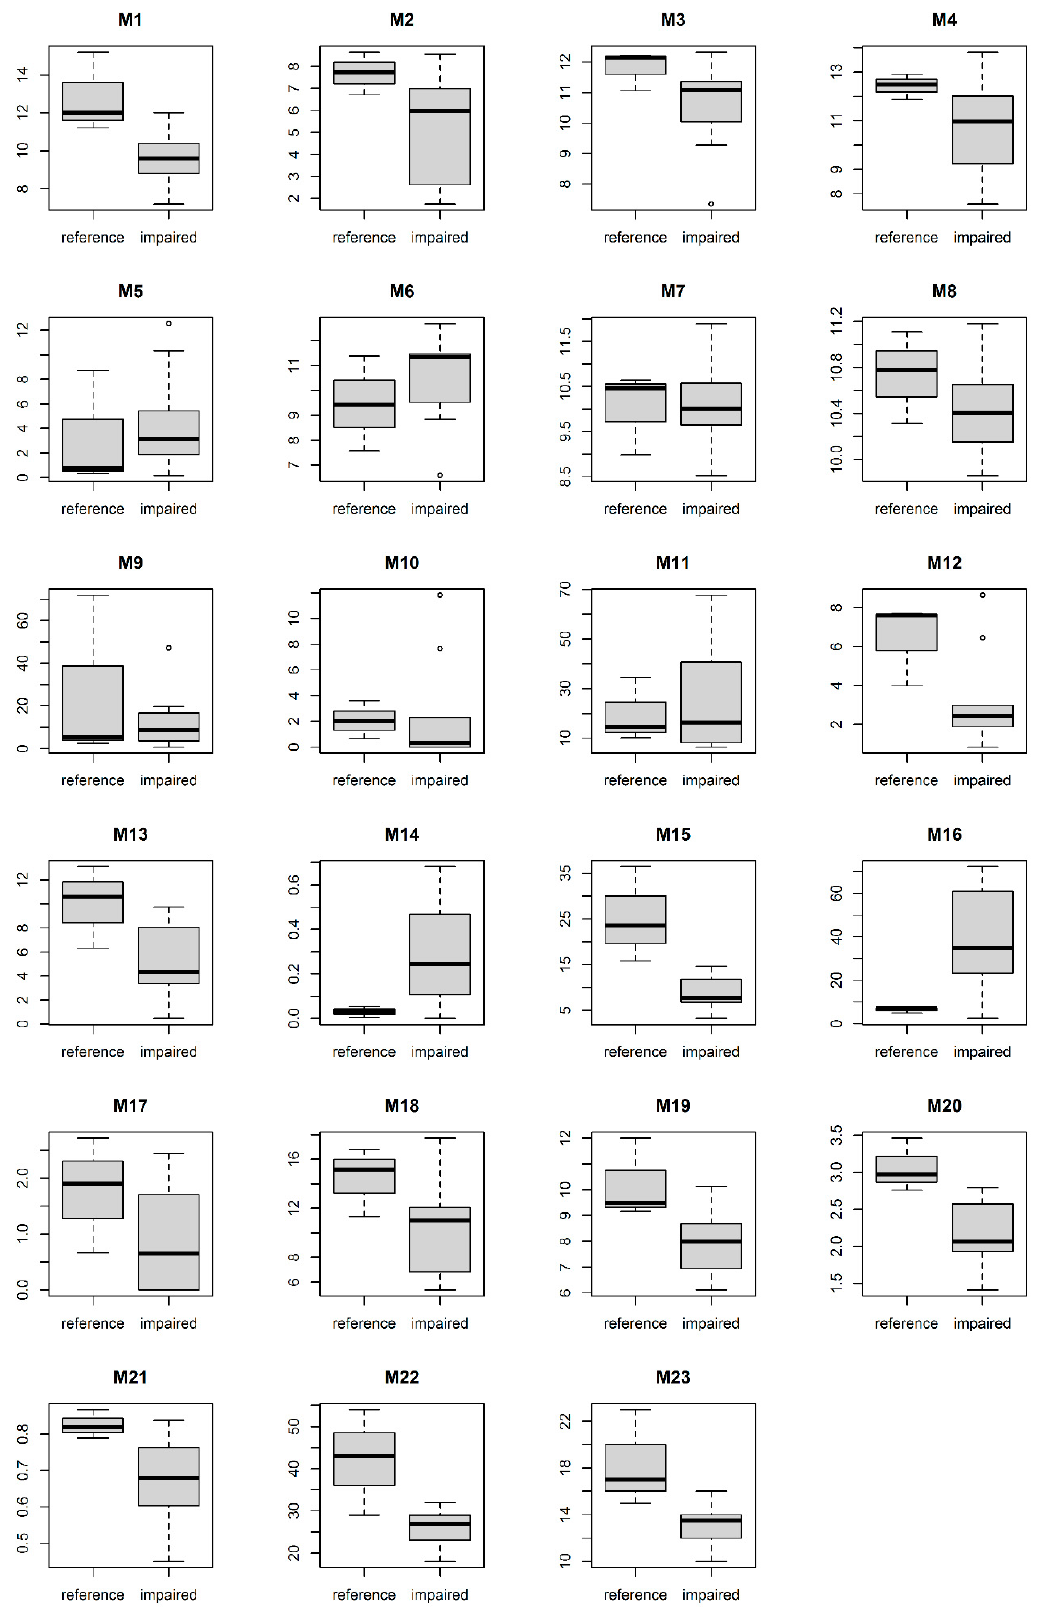
Figure 5. Box plots of 23 candidate benthic diatom index of biotic integrity (BD-IBI) metrics between reference and impaired sites in the Wutong River.